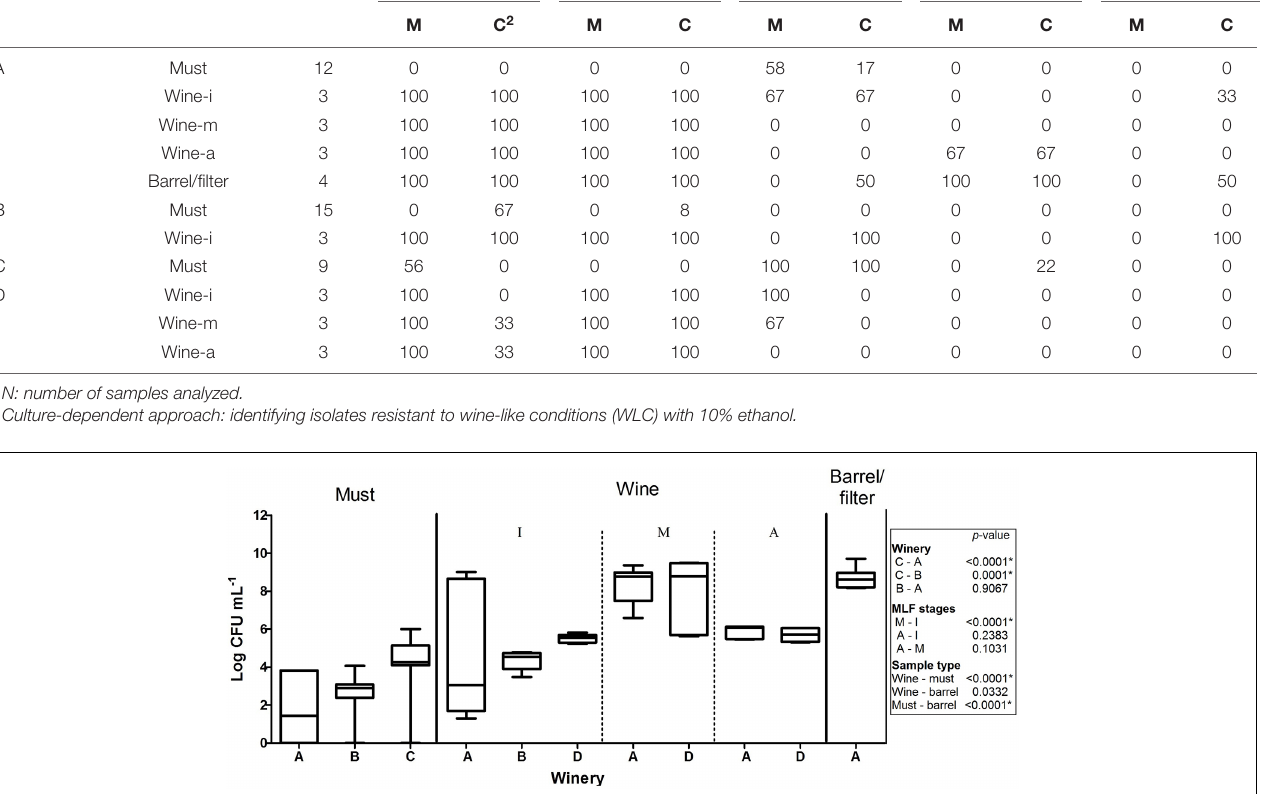
barrel/filter, of which around 90% did not resist 13%